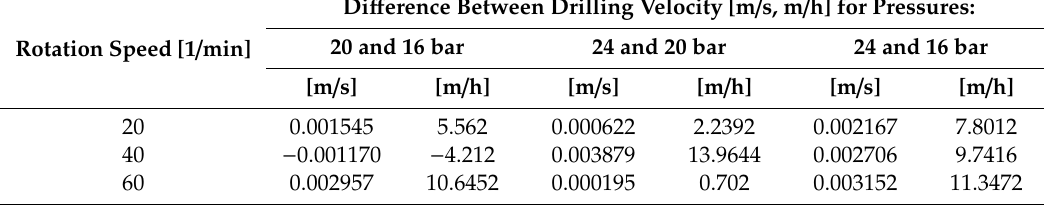
Table 9. Di ff erences between drilling velocity measured for various air pressures and drill rotation speeds of the 140 mm diameter drill bit, in the interval 90–108 m below ground